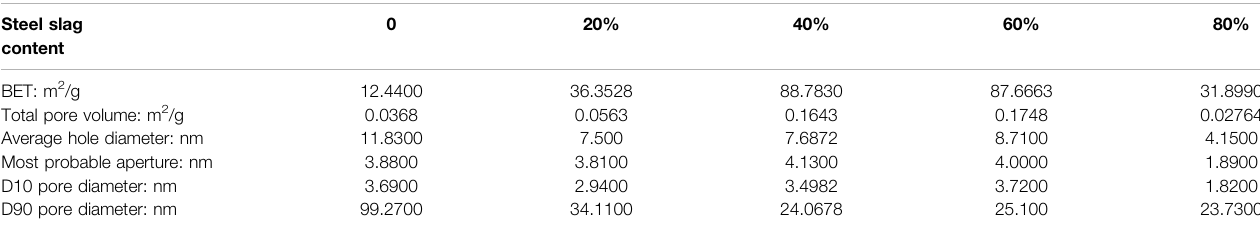
TABLE 5 | Pore size distribution parameters of adsorbents with different contents of steel slag. Steel slag